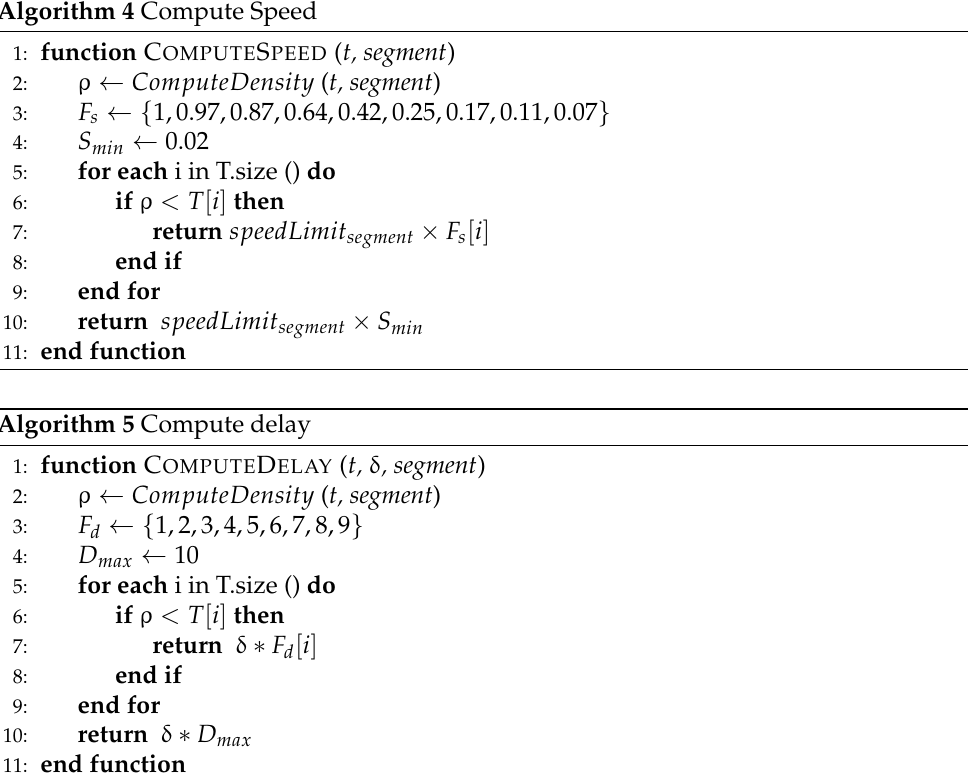
Algorithm 4 Compute Speed